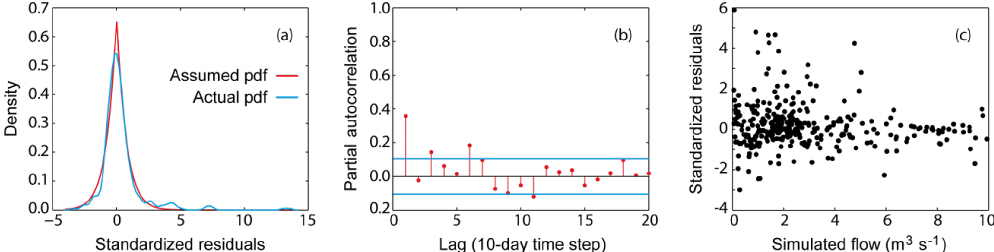
Figure 7. Formal checks of the statistical assumptions used to describe model residuals. Application to Model C (simulated for the validation period with the inferred maximum likelihood parameter set): (a) assumed and actual pdf; (b) partial autocorrelation; and (c) heteroscedasticity of standardized residuals.